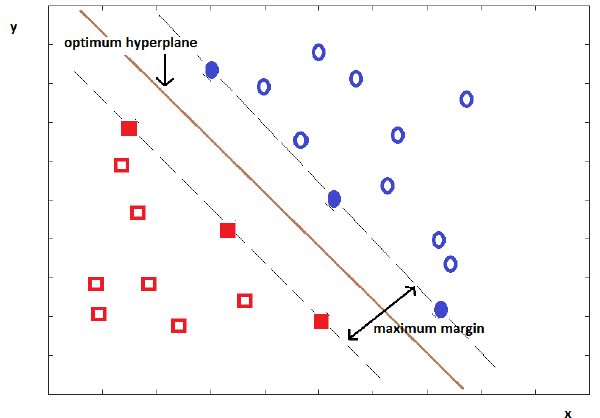
Figure 7. Hyperplane example for the support vector machine.